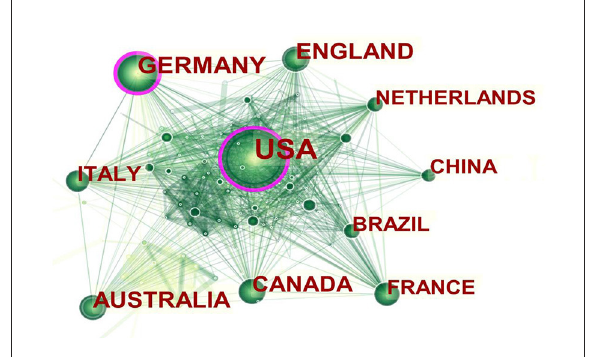
FIGURE3 Co-occurrence network mapping (larger circles indicate more publications; purple circles indicate key nodes, i.e., centrality ≥ 0.1. The higher the centrality of a node, the more influential and important it is).